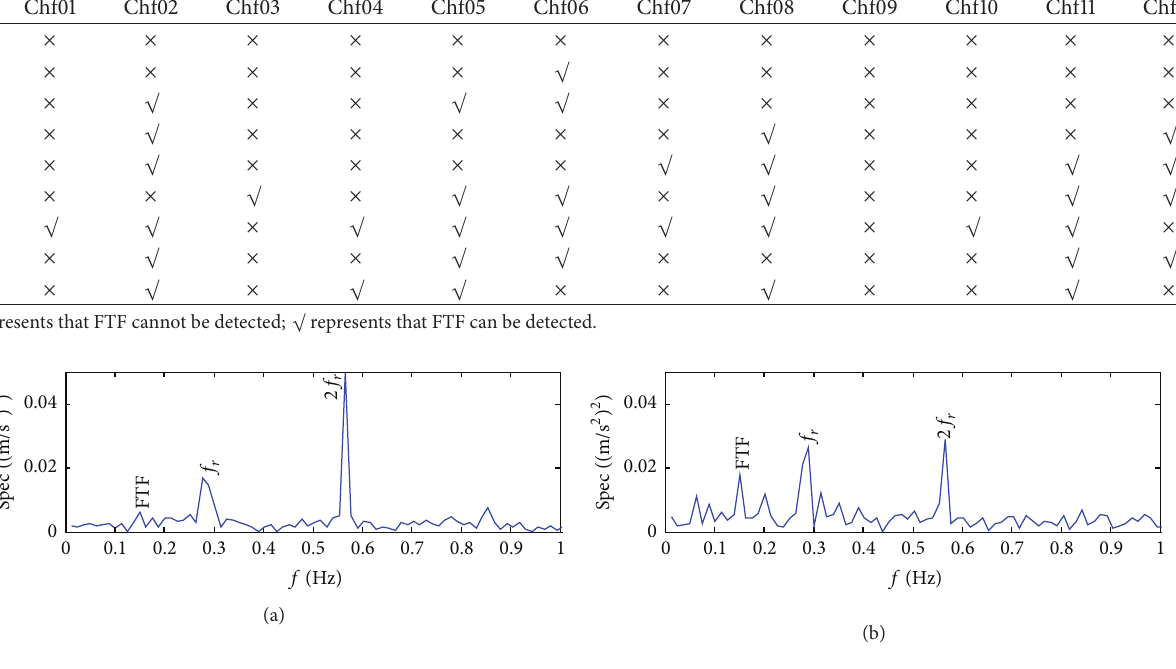
Figure 14: Slices of the MuSEnS at scale 15 in chn08 and chf08. (a) Normal and (b) fault.